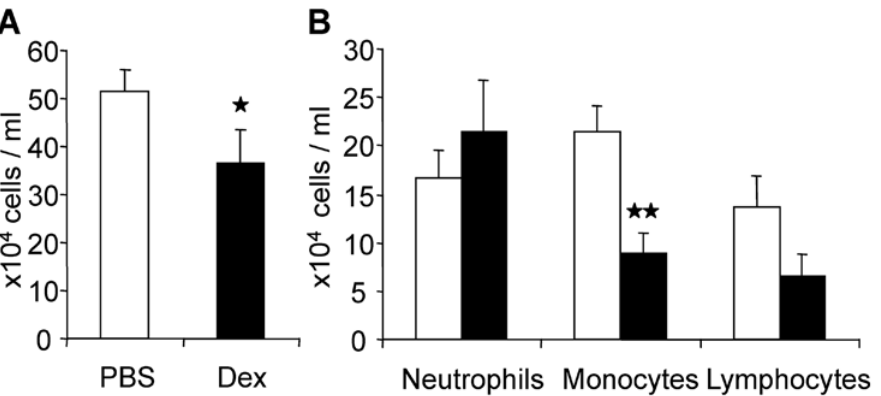
Figure 4. Anti-inflammatory effect of dexamethasone. Open bars represent PBS treated animals and black bars represent dexamethasone animals (dosage 50 mg/kg). (a) Leukocyte infiltration was reduced by dexamethasone treatment from 51.5 6 10 4 ( 6 4.7) to 36.5 6 10 4 ( 6 7.1) cells/ milliliters of lavage. (b) Dexamethasone treatment had no effect on neutrophil migration, 16.6 6 10 4 ( 6 2.9) and 21.5 6 10 4 ( 6 5.2) cells/ml were found in PBS control group and dexamethasone treated animals, respectively. In contrast, accumulation of monocytes and lymphocytes were reduced